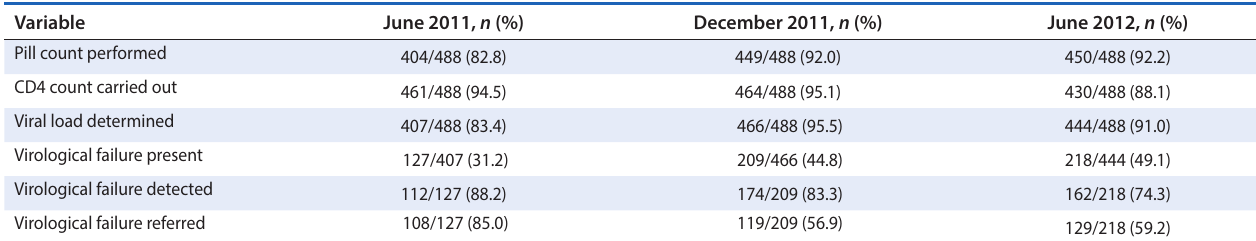
Table 3: Results of the monitoring of the study patients from June 2011 to June 2012 ( n = 488)